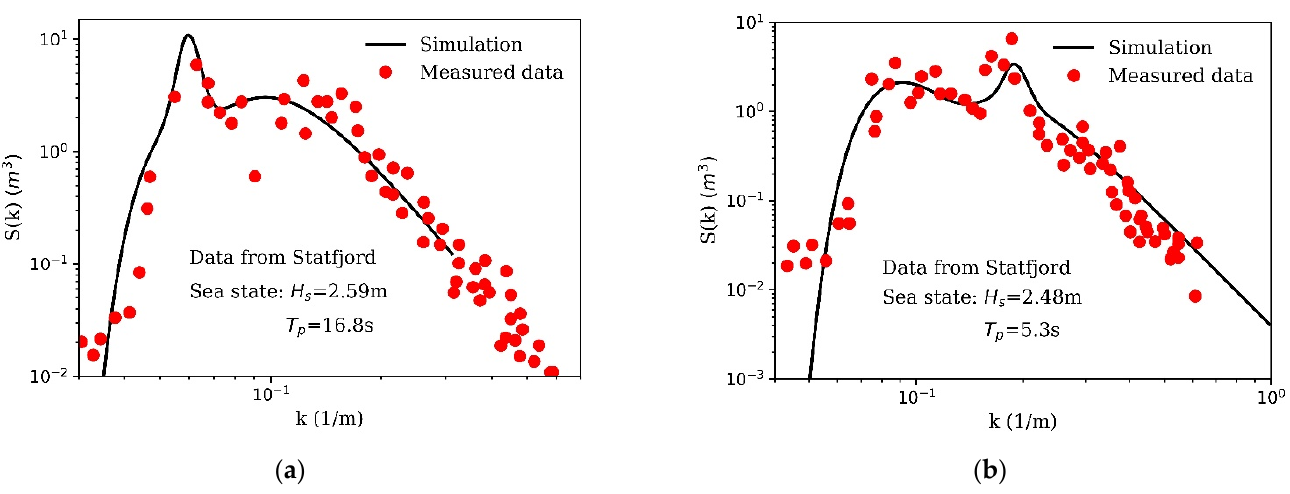
5 of 20 Table 1. Parameter calculation formula under different waveforms. Parameter